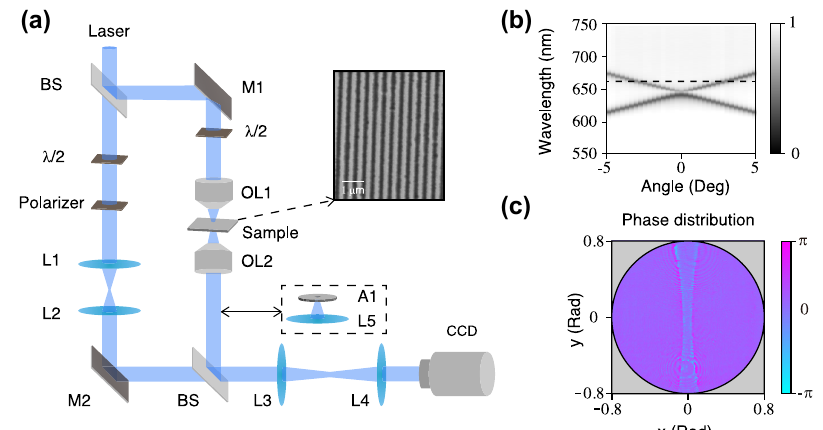
Figure 2: Experimental system and